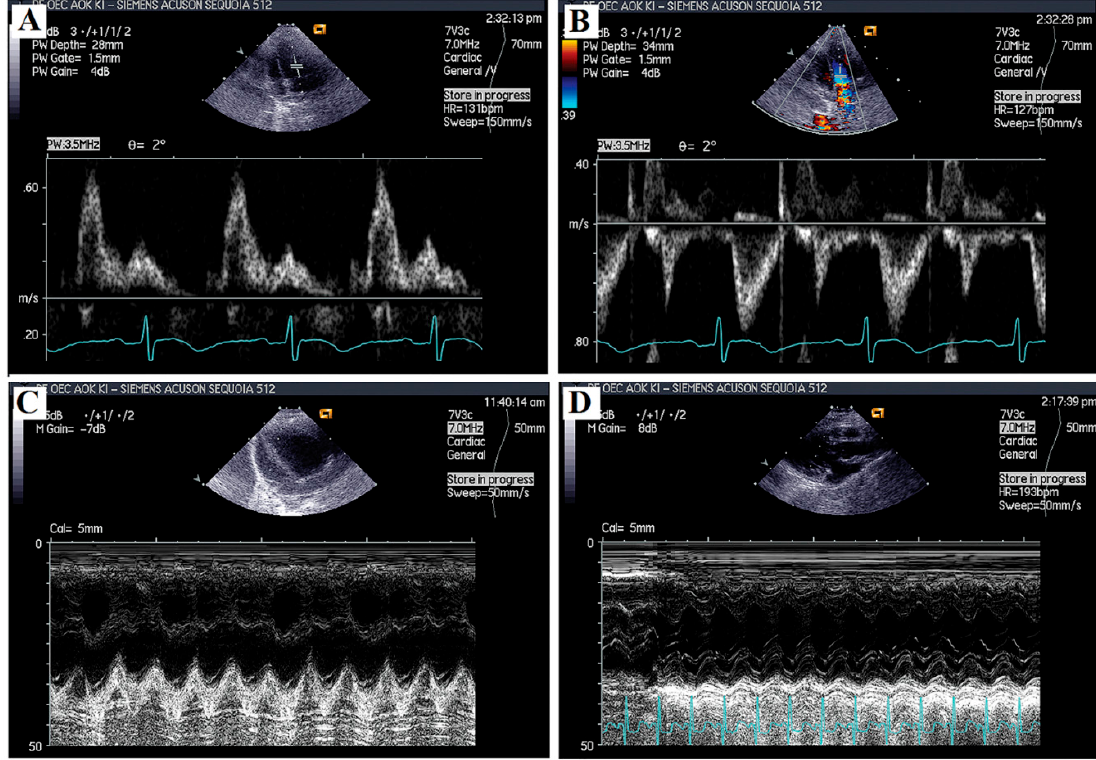
Figure 5. Representative images of echocardiographic measurements. ( A ) Doppler image, mitral inflow velocities; ( B ) color Doppler image, velocity of left ventricle outflow tract; ( C ) M-mode image, tricuspidal annular plane systolic excursion (TAPSE); ( D ) M-mode image, parasternal long axis view (PLAX) of left ventricle.